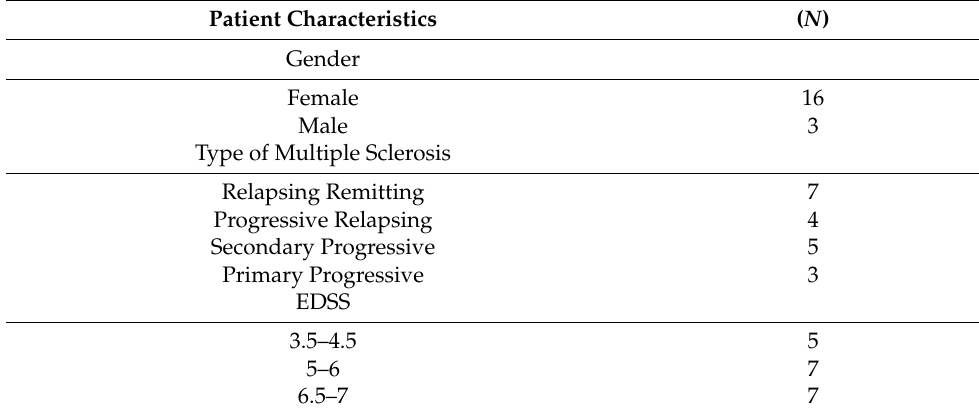
Table 1. Characteristics of patients recruited in the study.